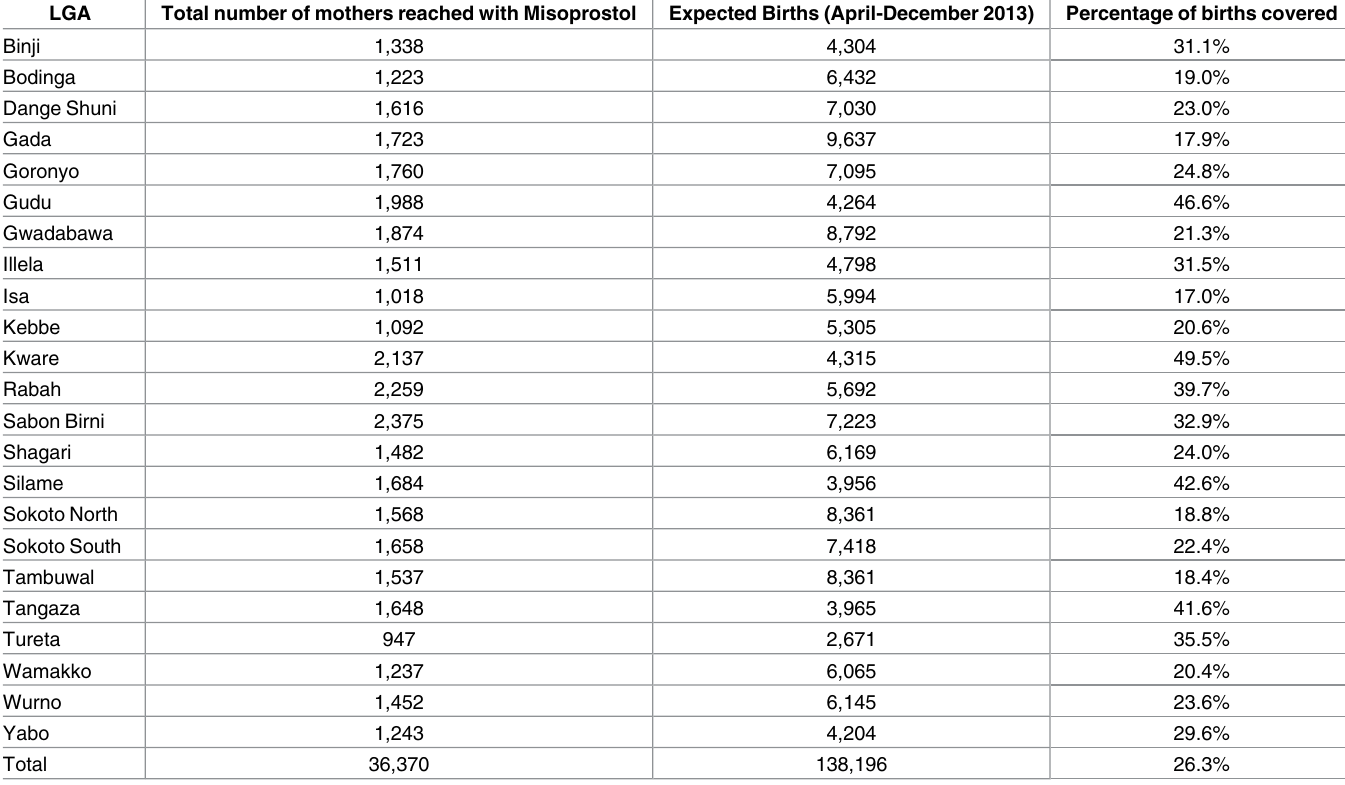
Table 2. Percentage of Births that receivedMisoprostol in each Local Government Area (LGA) between April and December of 2013. LGA Total number of mothers reached with Misoprostol Expected Births (April-December 2013)